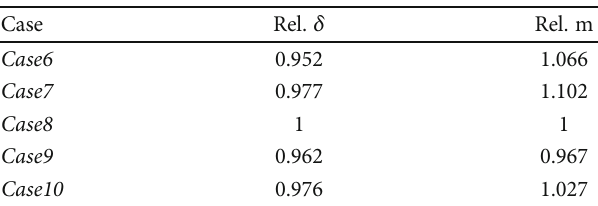
Table 6: Performance comparisons for di ff users with di ff erent blade thickness distributions.